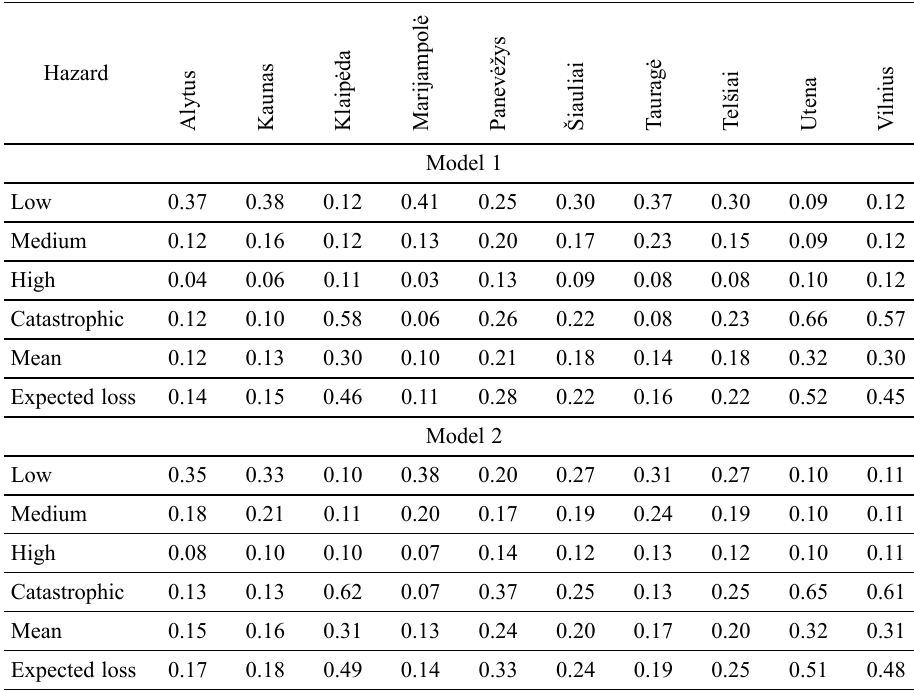
Table 3. County-level measures of yield risk for